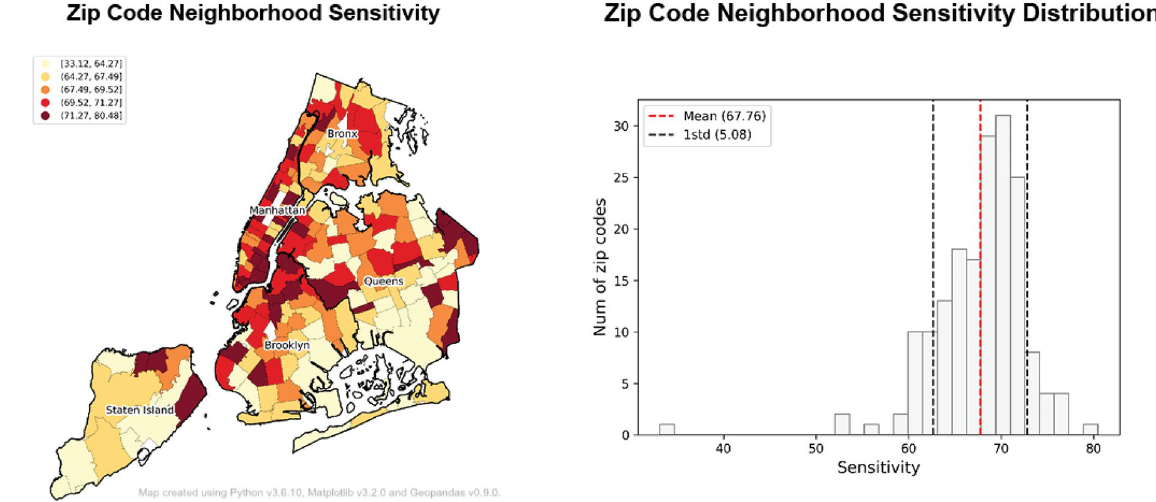
Figure 3. Zip code level sensitivity